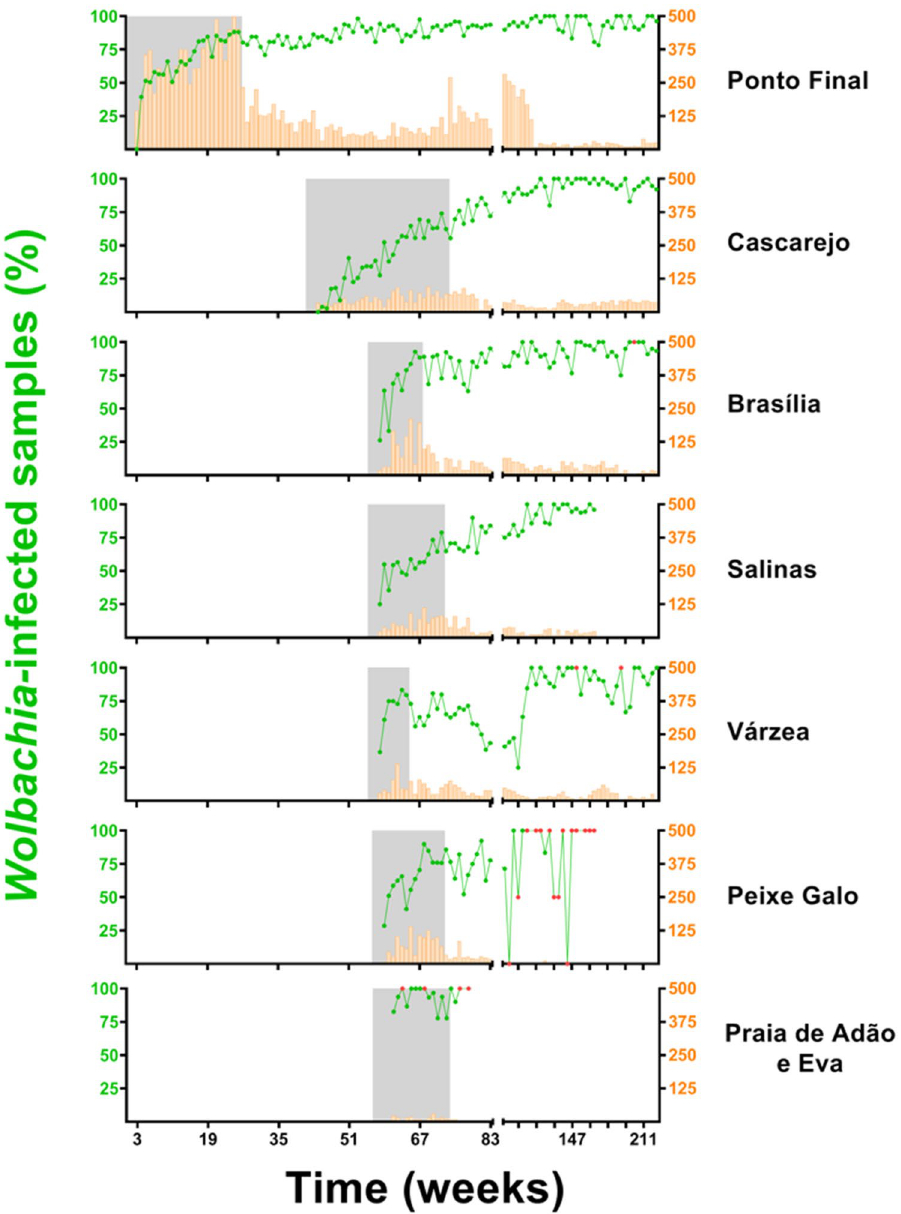
Figure 2. Wolbachia ’s spread across Niteroi’s suburb Jurujuba. Over a period spanning 73 weeks, w Mel-infected eggs were gradually released across all sectors of Jurujuba: Ponto Final, Cascarejo, Brasília, Salinas, Várzea, Peixe Galo and Praia de Adão e Eva (release interventions depicted under grey shaded areas). Infection indexes (%) are plotted as line-connected dots (green), following the vertical left axis, whereas the sample sizes are plotted as histograms (orange), following the vertical right axis. Small-sized samples (N < 5) were marked in red. The horizontal axis represents time, in number of weeks, since the beginning of egg-releases in Ponto final (August 2015) until more recent days (December 2019). Note that the horizontal axis is split into two fragments, in which the data account for 1-week (left fragment) or 4-week bins (right fragment). Ticks are scaled accordingly to represent a 16-week bin. Graphs were created with GraphPad Prism 8 (https:// www. graph pad.